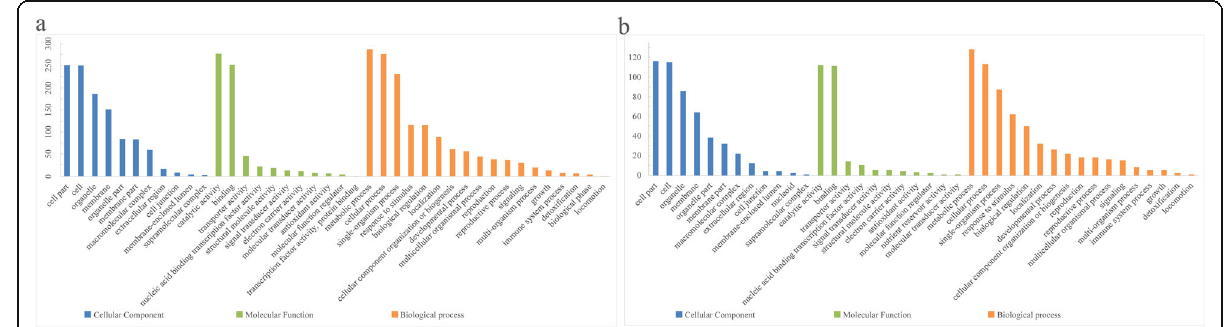
Fig. 2 The GO classification of the genes for PH ( a ) and FBN ( b ) in stable